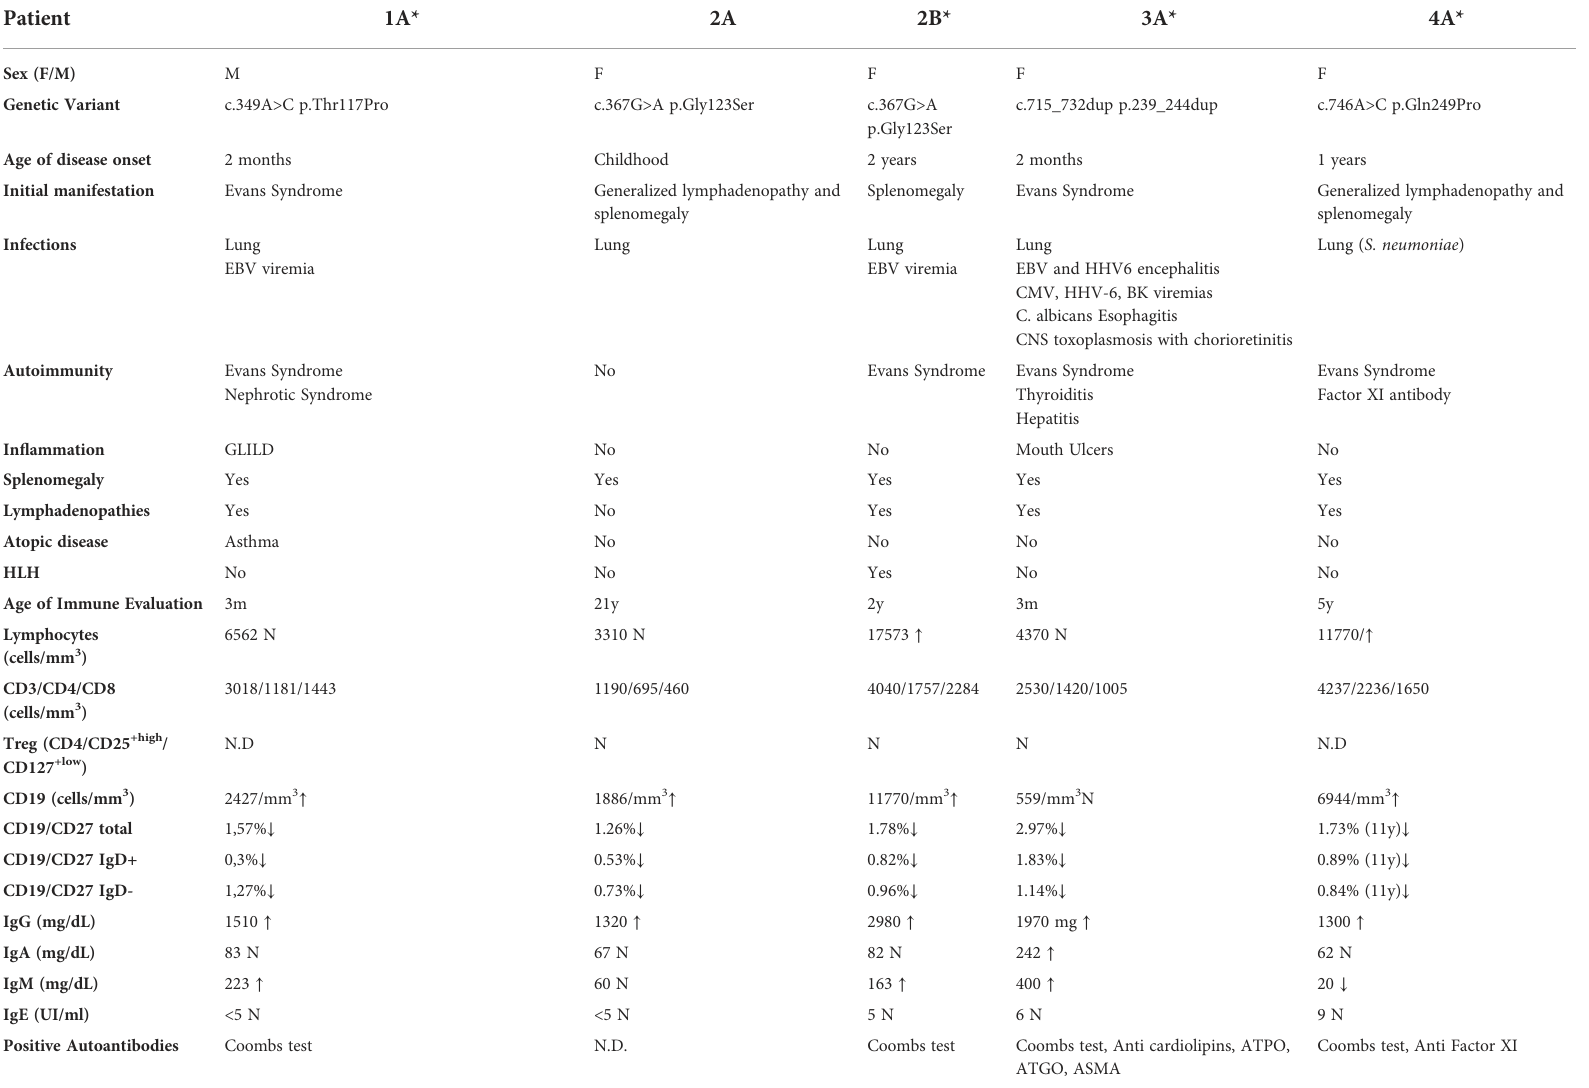
TABLE 1 Demographic, clinical features, immune evaluation, treatment, and outcome in BENTA